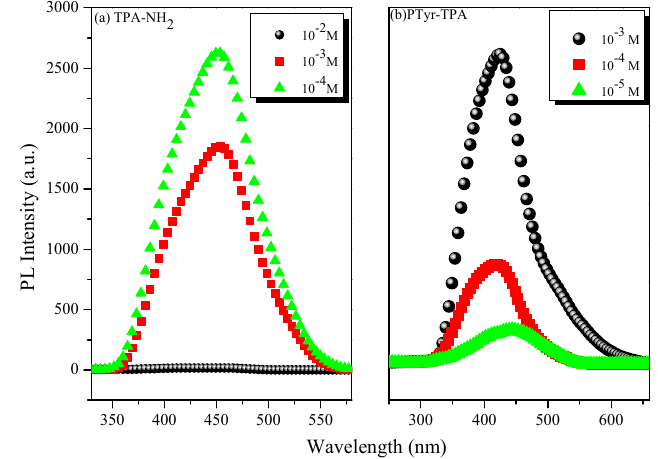
Figure 6. PL spectra (excitation wavelength: 330 nm) of: ( a ) TPA-NH 2 ; and ( b ) PTyr-TPA as solutions in THF.